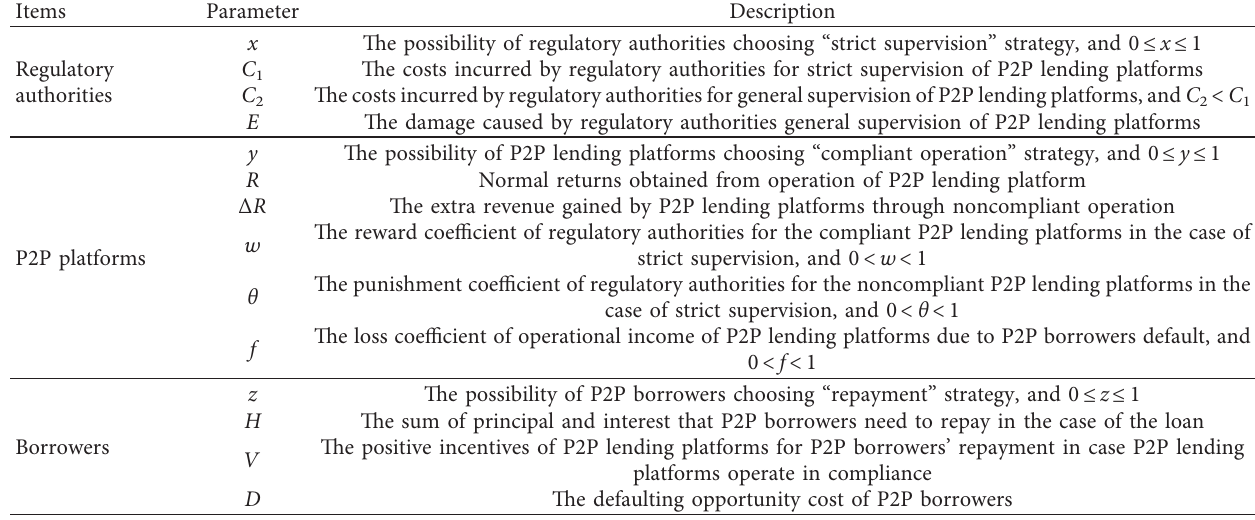
Table 1: Symbols and descriptions of the